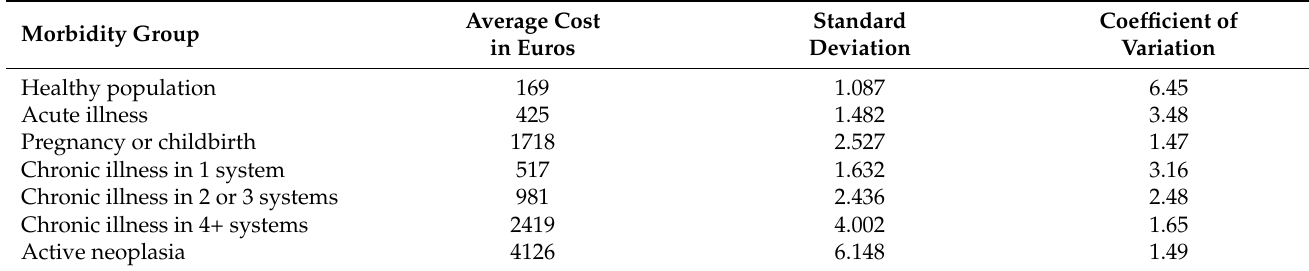
Table 2. Average costs by morbidity group in euros.